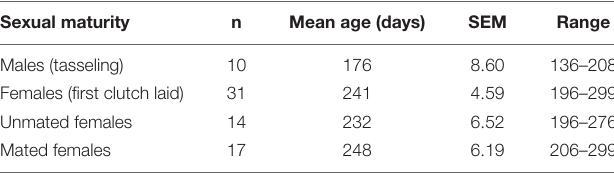
TABLE 2 | Mean age of O. chierchiae at estimated sexual